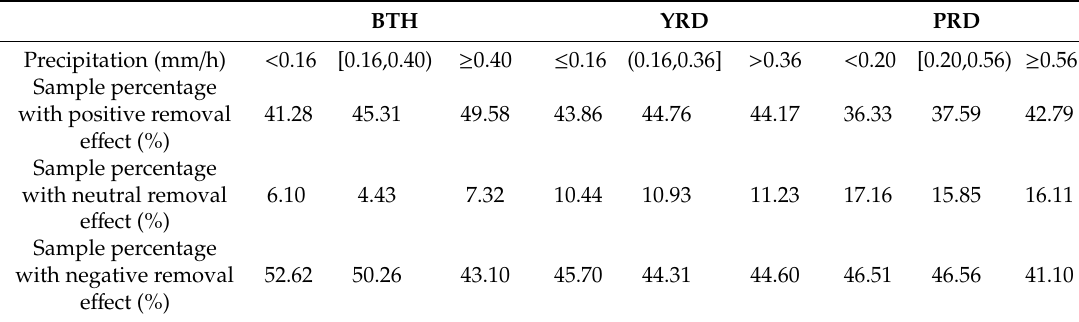
Table 1. Sample percentage with positive, neutral, and negative removal e ff ect for three equal-sample bins of precipitation intensity in the BTH, YRD, and PRD regions. BTH YRD PRD Precipitation (mm / h) < 0.16 [0.16,0.40) ≥ 0.40 ≤ 0.16